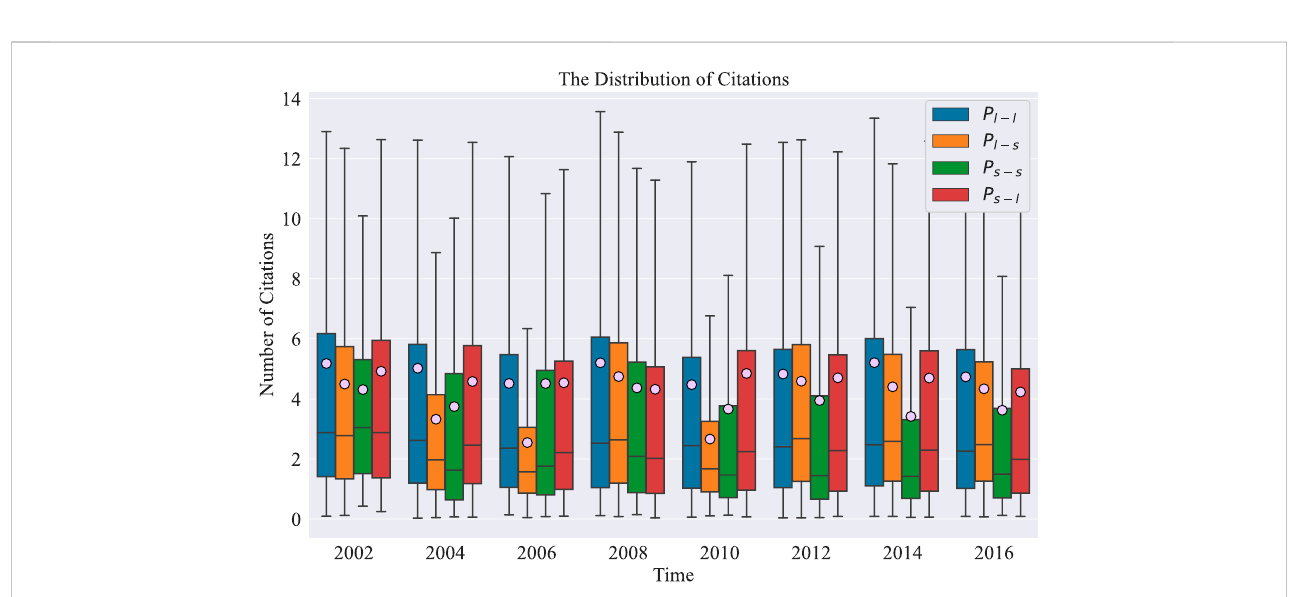
FIGURE 6 The evolution of citations for scientists within different interdisciplinary types. We classify scientists as the large discipline (blue box), the large across the smalldiscipline(orangebox),thesmalldiscipline(greenbox),andthesmallacrosslargediscipline(redbox).Thesolidlineandthepinkdotintheboxrepresent the median and the average number of citations for scientists,